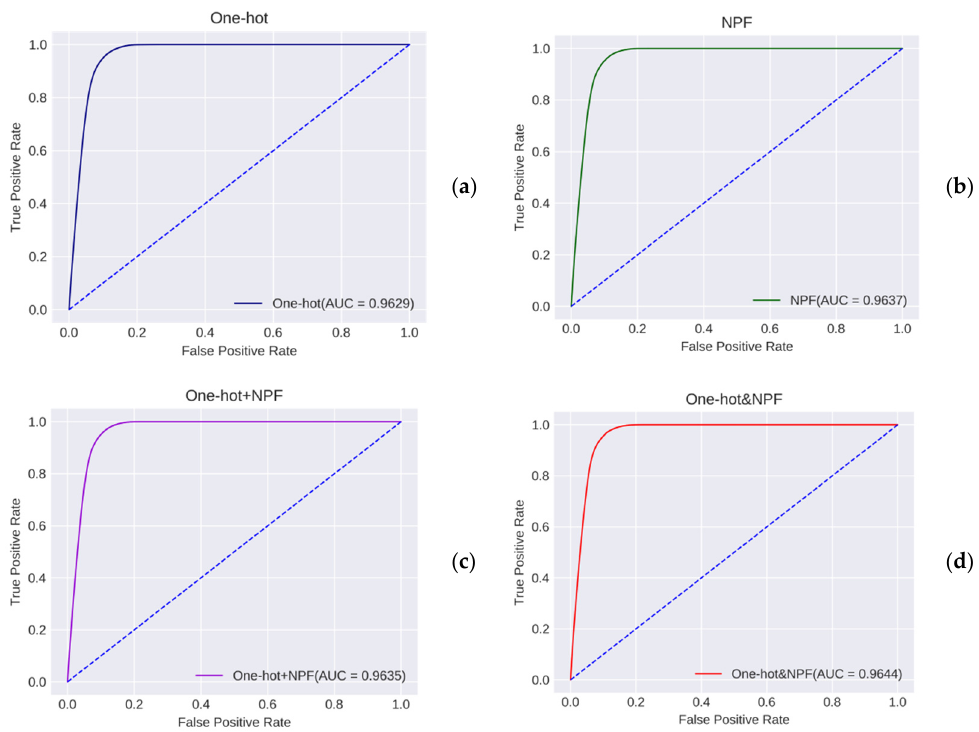
Figure 4. ROC curves of different predictors with different features. ( a ) The ROC curve based on the one-hot features. ( b ) The ROC curve based on the NPF features. ( c ) The ROC curve based on the one-hot+NPF features. ( d ) The ROC curve based on the one-hot&NPF features.